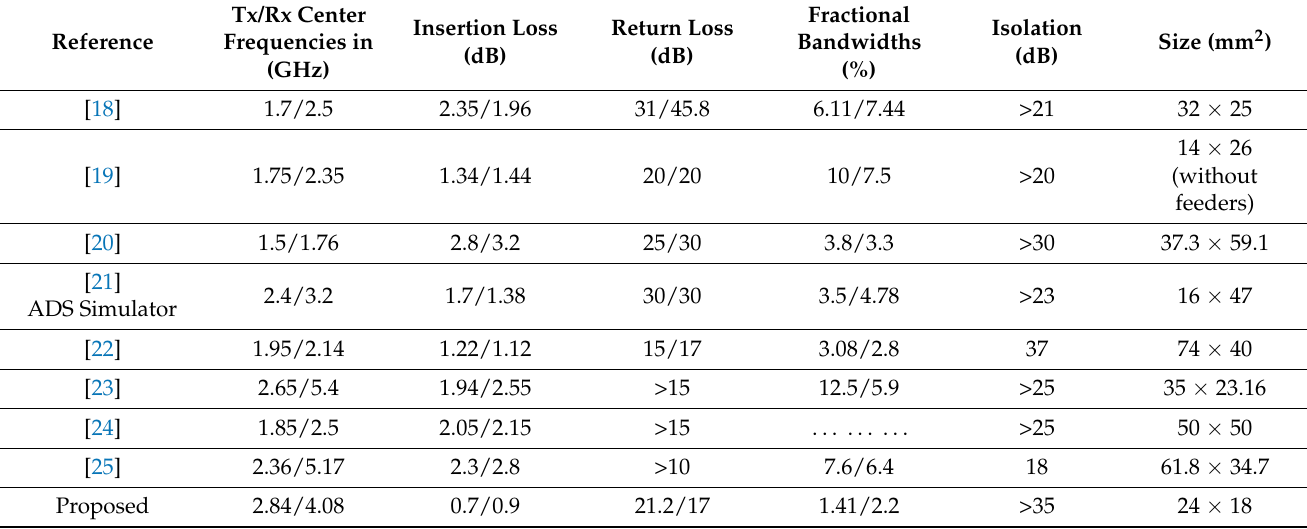
Table 2. Comparing diplexers in this research article with the other reported studies.